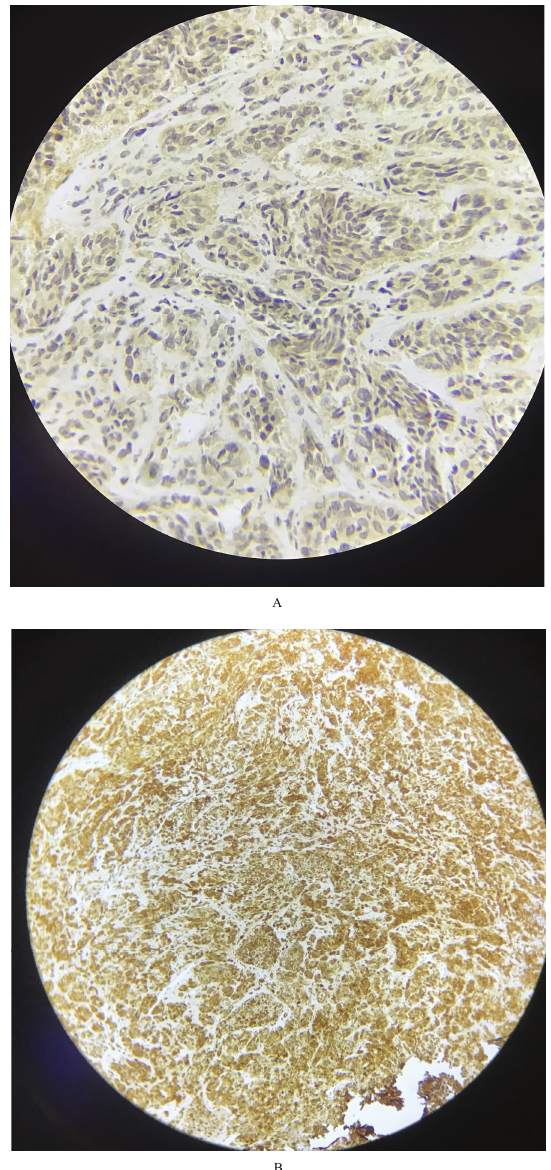
Figure 3 : (A) Positive reaction of neoplastic cells for GFAP. (B) Positive reaction pattern of neoplastic cells for vimentin (IHC staining, ×